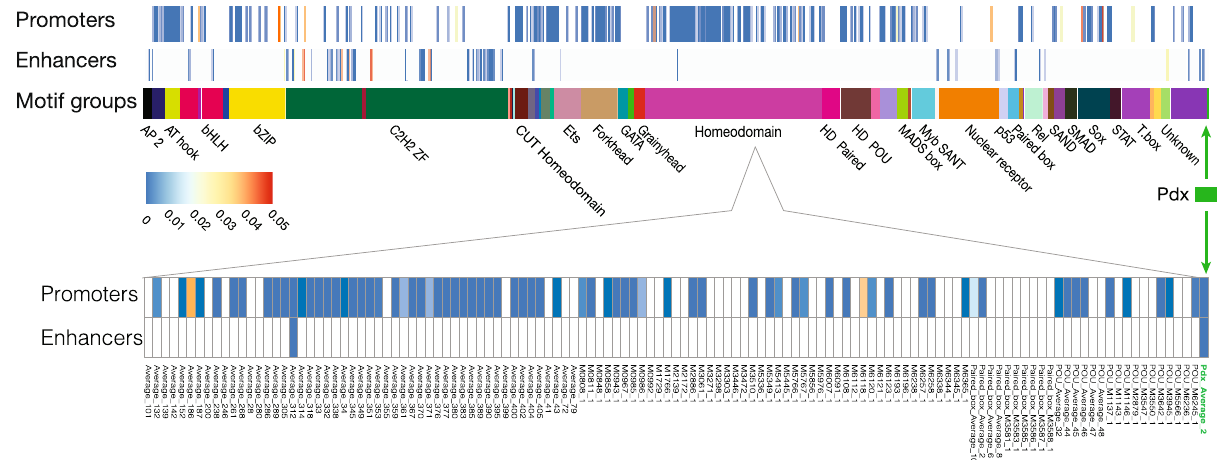
Fig. 3 Homeodomain TFBS and Pdx consensus motif are enriched in open chromatin promoter and enhancer peaks. TFBS enrichment test p values after Bonferroni correction were assessed for Pdx consensus motif and 583 other consensus motifs.